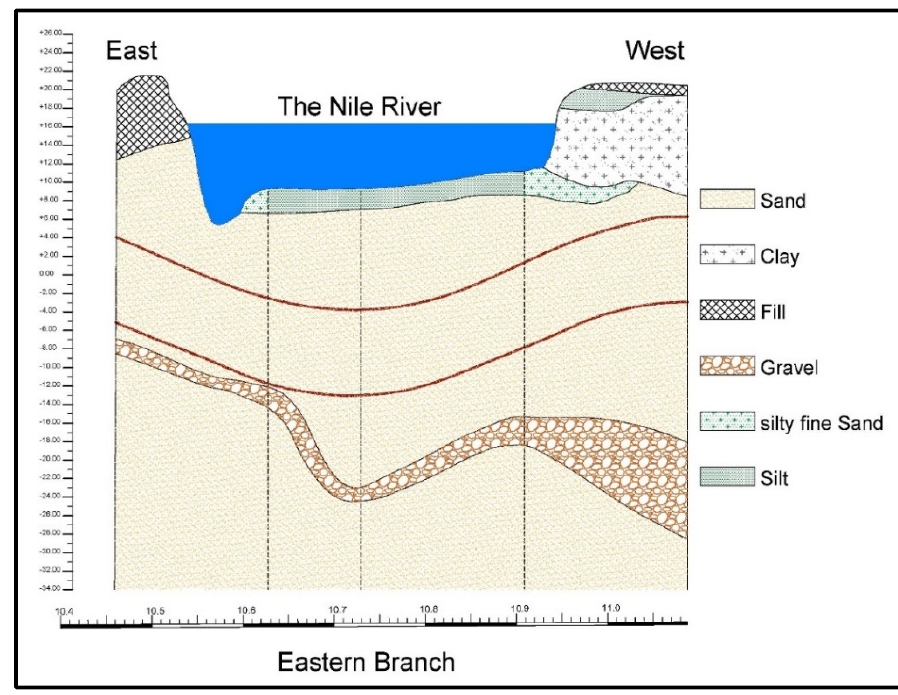
Figure 5. Geological section under the east branch of the Nile River.